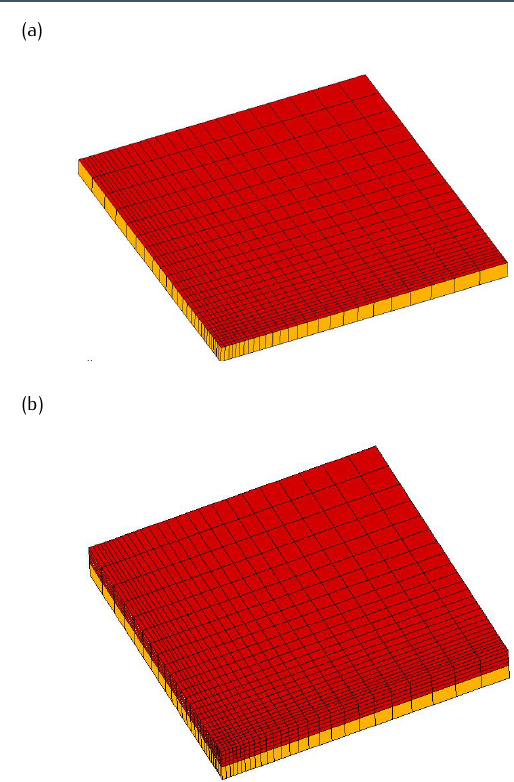
Figure 14. Finite Element models, (a) Shell elements, (b) Solid